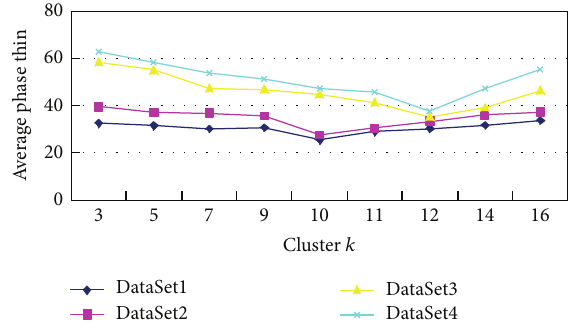
Figure 4: 𝑘 values for experiments.